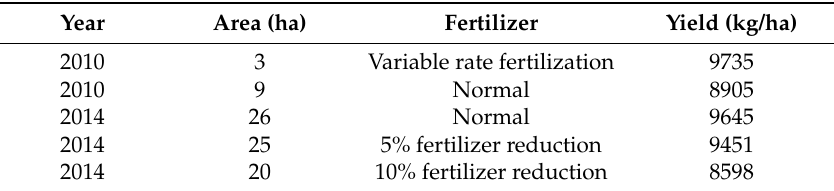
Table 6. The variable rate fertilization experiments in 2010 and 2014.